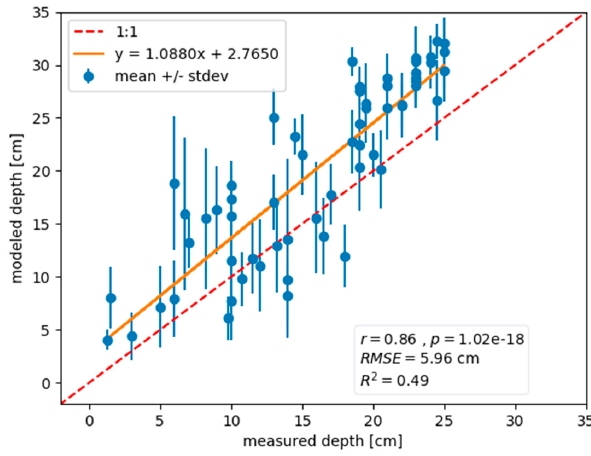
Figure 9. Scatter plot of measured vs. modeled pond depth ( n = 60).